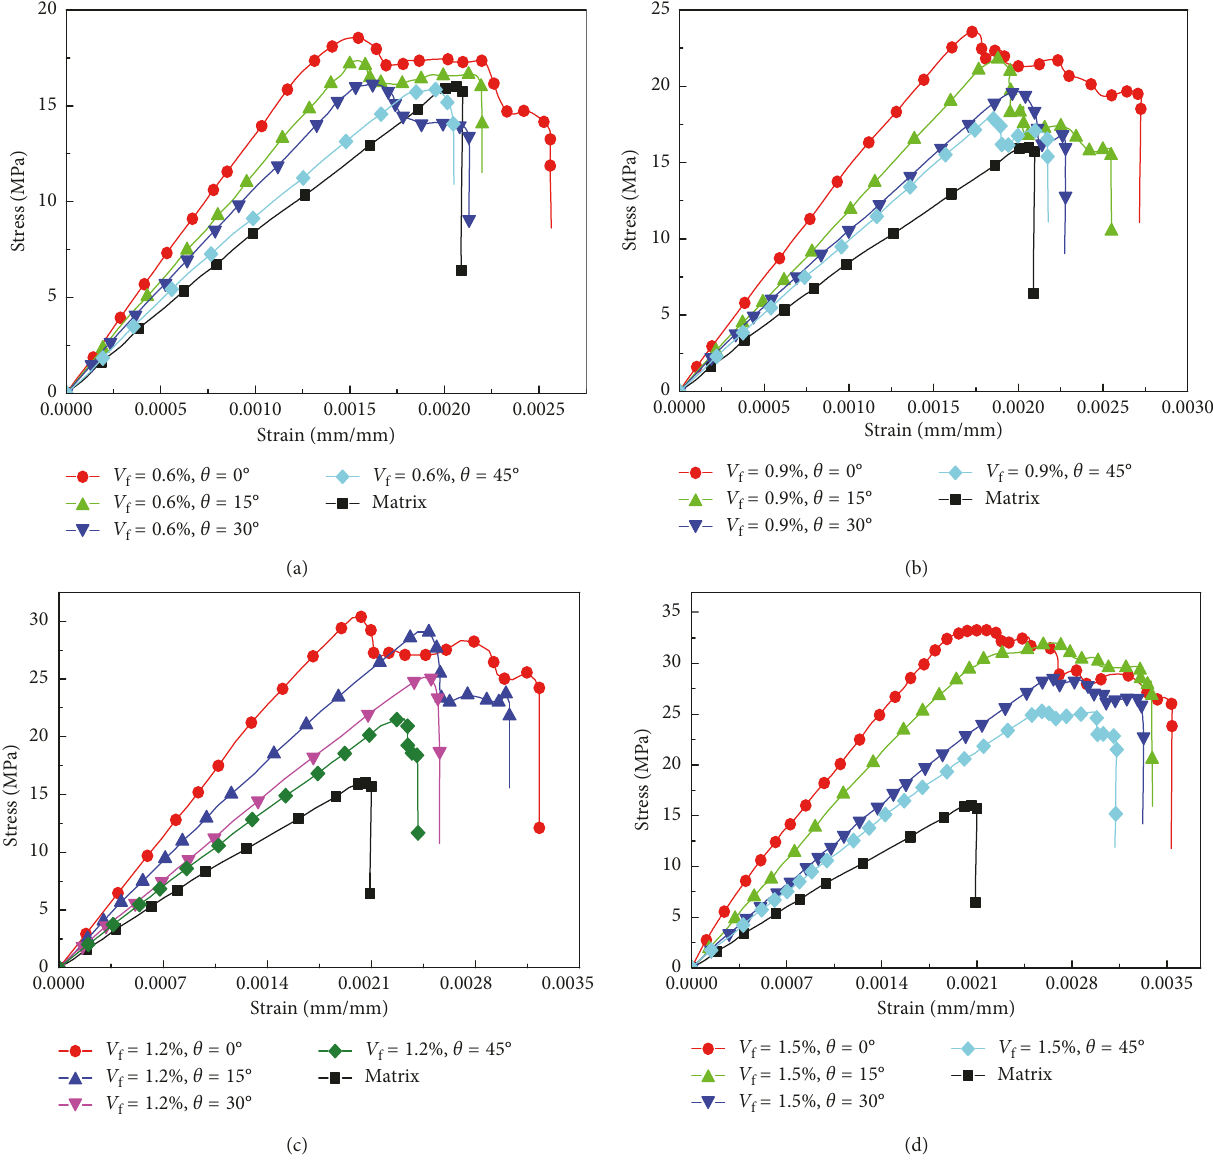
Figure 4: Tensile stress-strain curves of BF/EP composite materials with different orientations and different volume fractions of